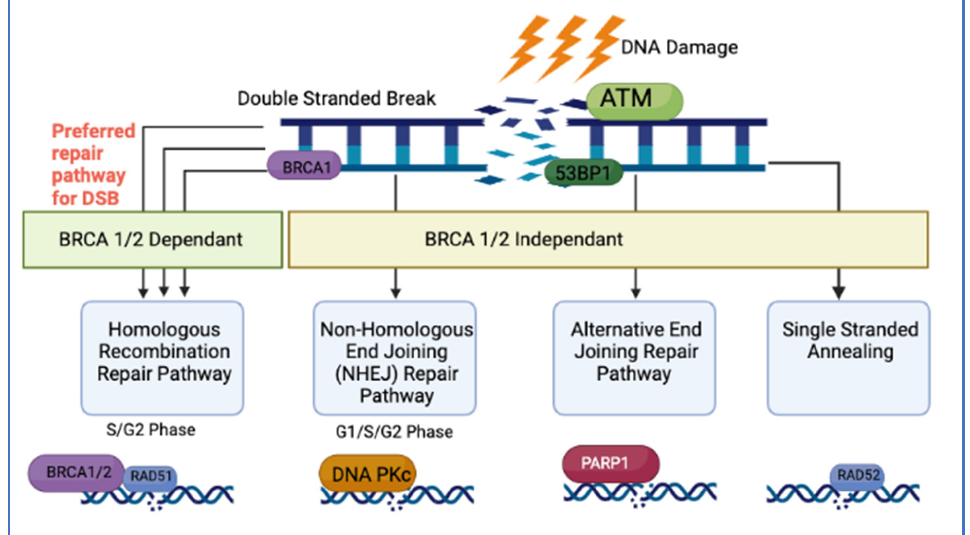
Figure 1. Repair Pathways for DSBs.